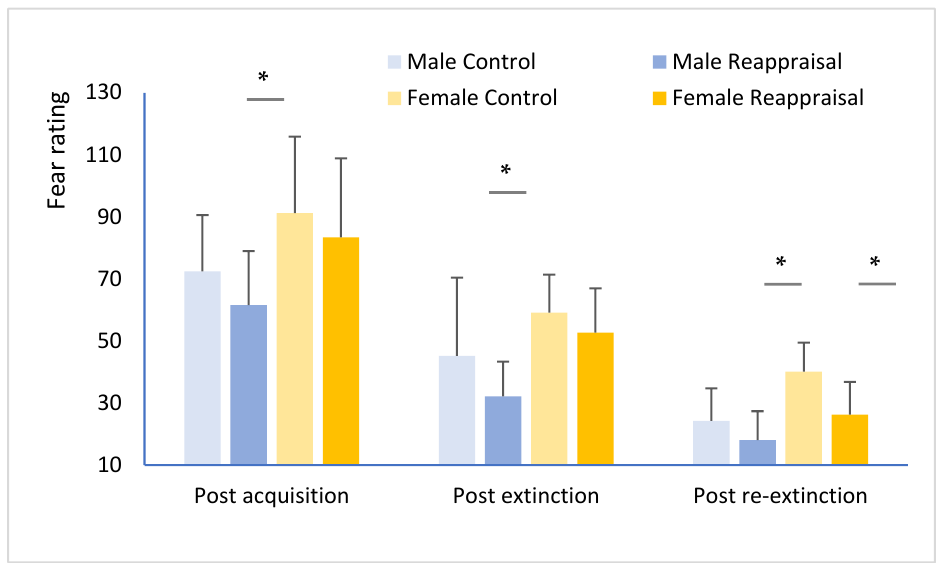
Figure 1. CS+ fear ratings. Post acquisition, post extinction, and post re-extinction, for the reappraisal and control groups * p < 0.05.